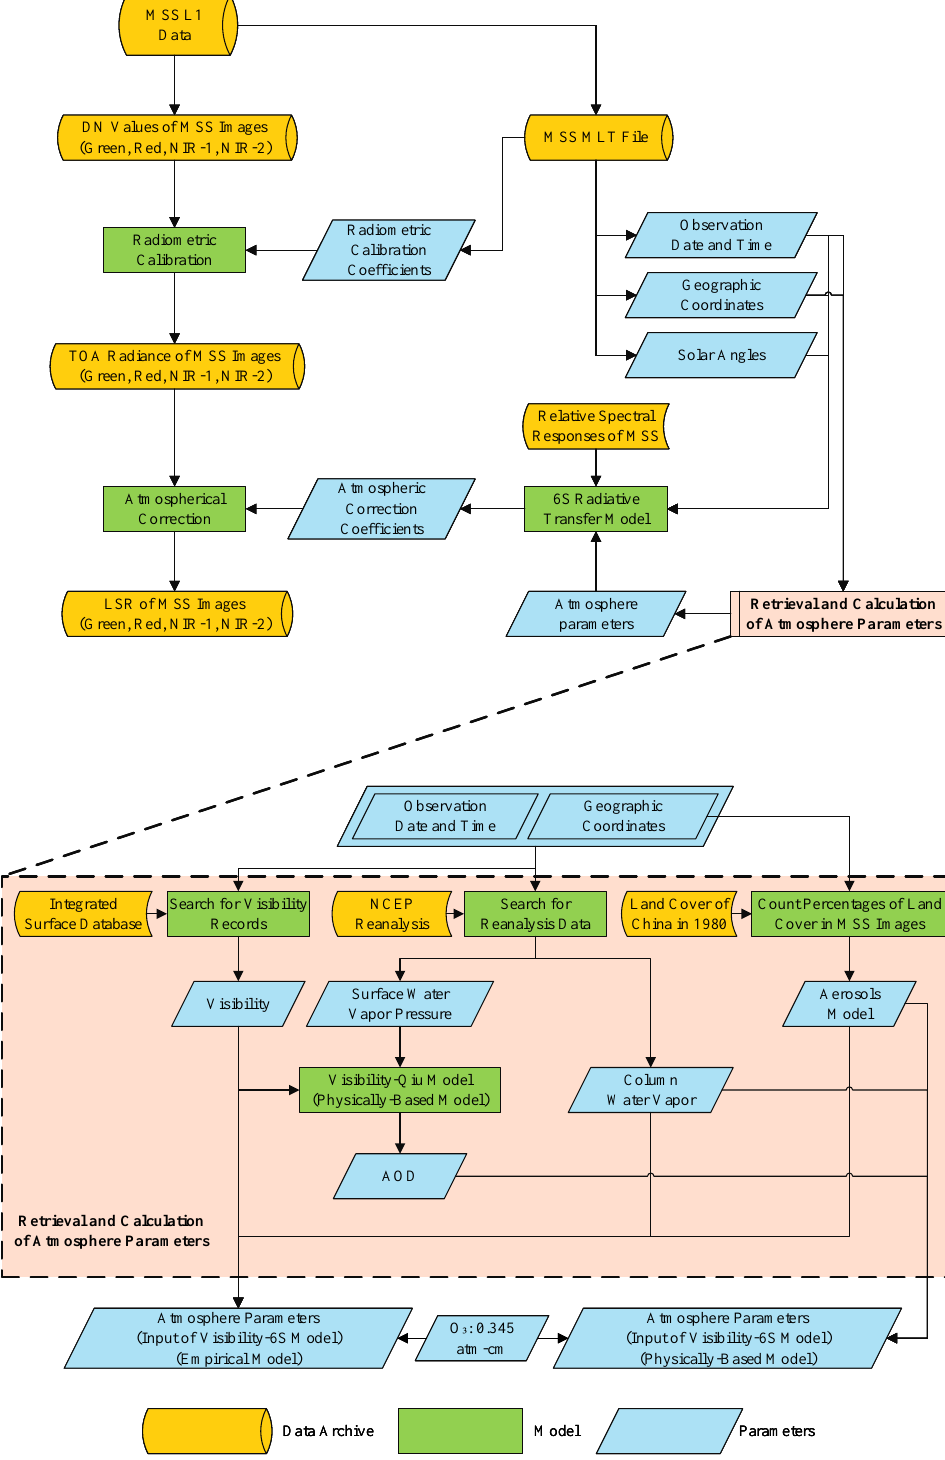
Figure 3. Workflow for generating the LSR data of